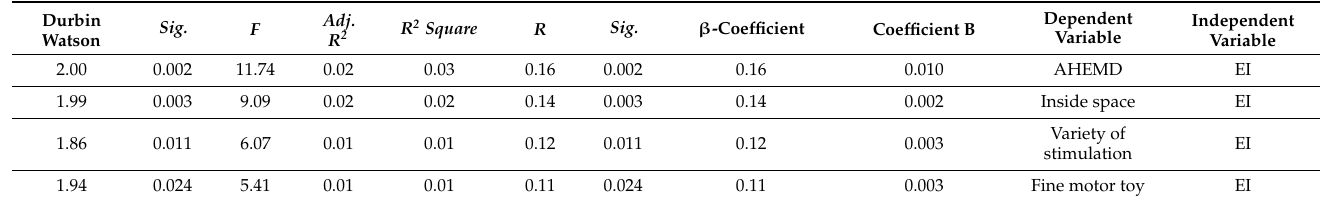
Table 3. Linear regression of EI on AHEMD and its factors.